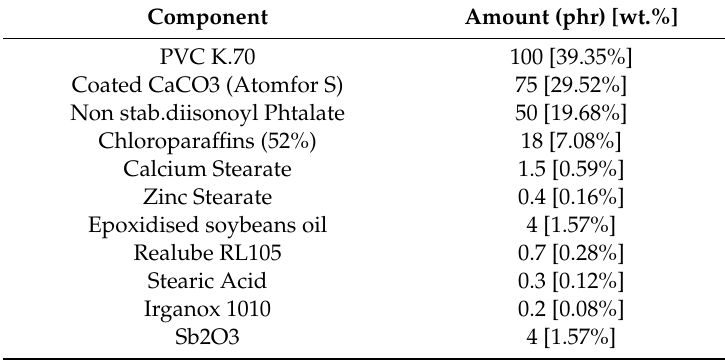
Table 1. Composition of the Plasticized-Poly(vinyl chloride) (P-PVC) formulation.